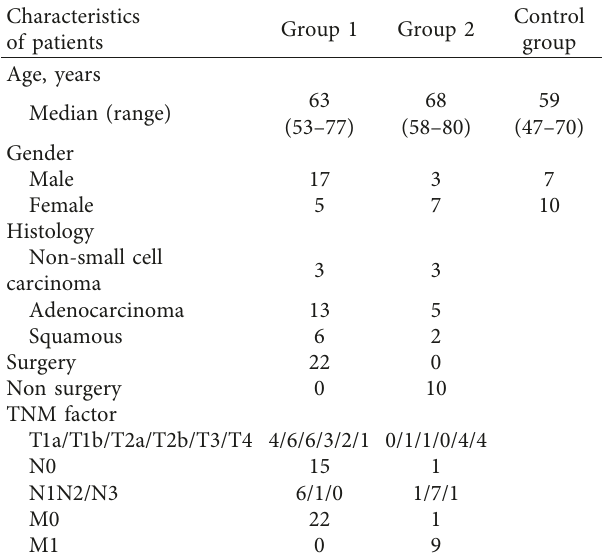
Table 1: Patients and clinical tumor